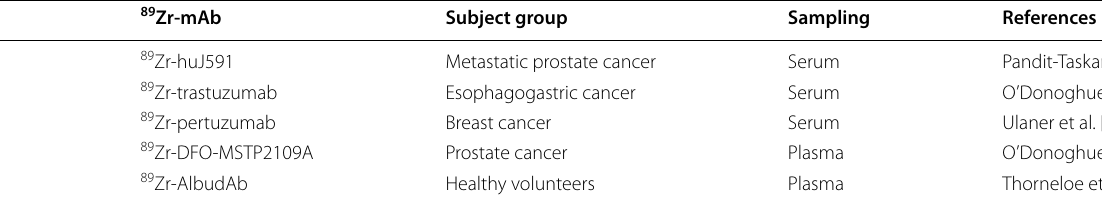
Table 1 Five papers provided 89 Zr‑mAb plasma/serum activity concentration data 89 Zr-mAb